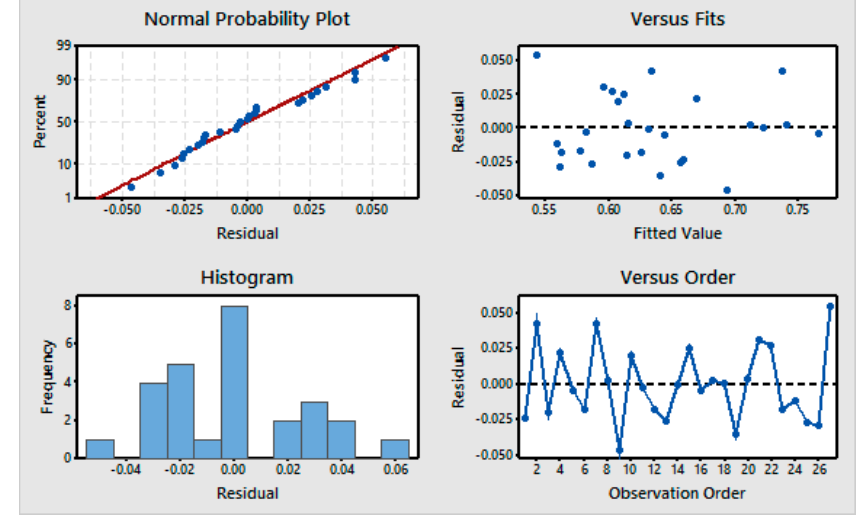
Figure 7. Residual plots for the means [Response: GRG].